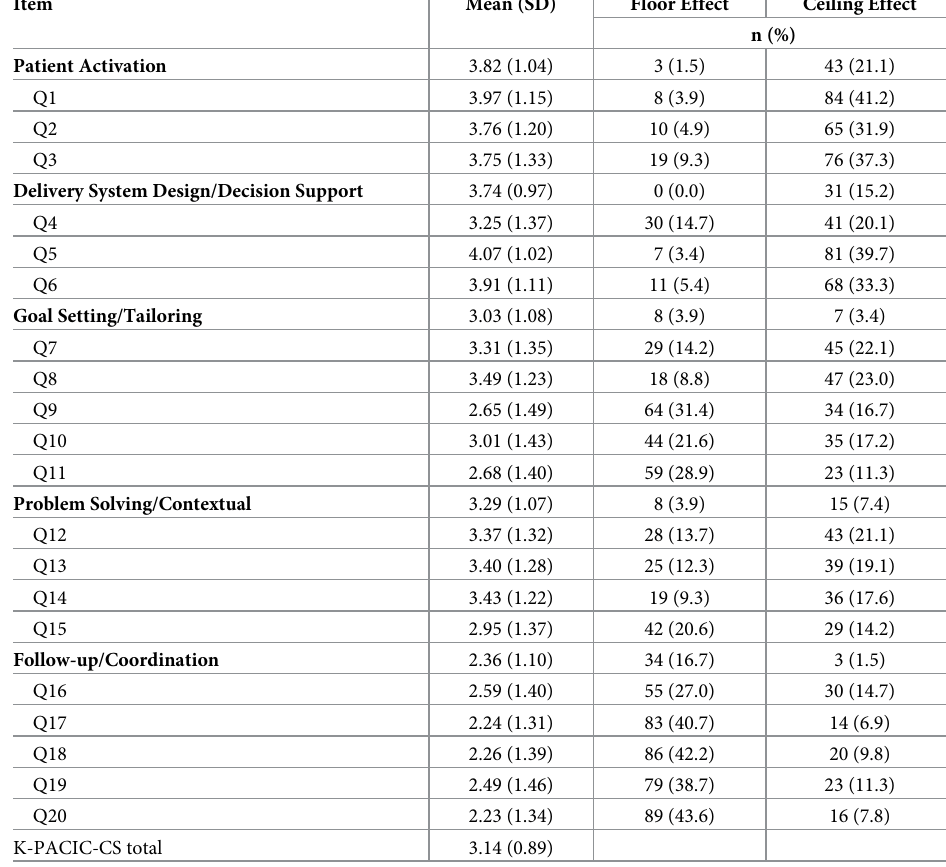
Table 2. Descriptive statistics of the K-PACIC-CS (N =